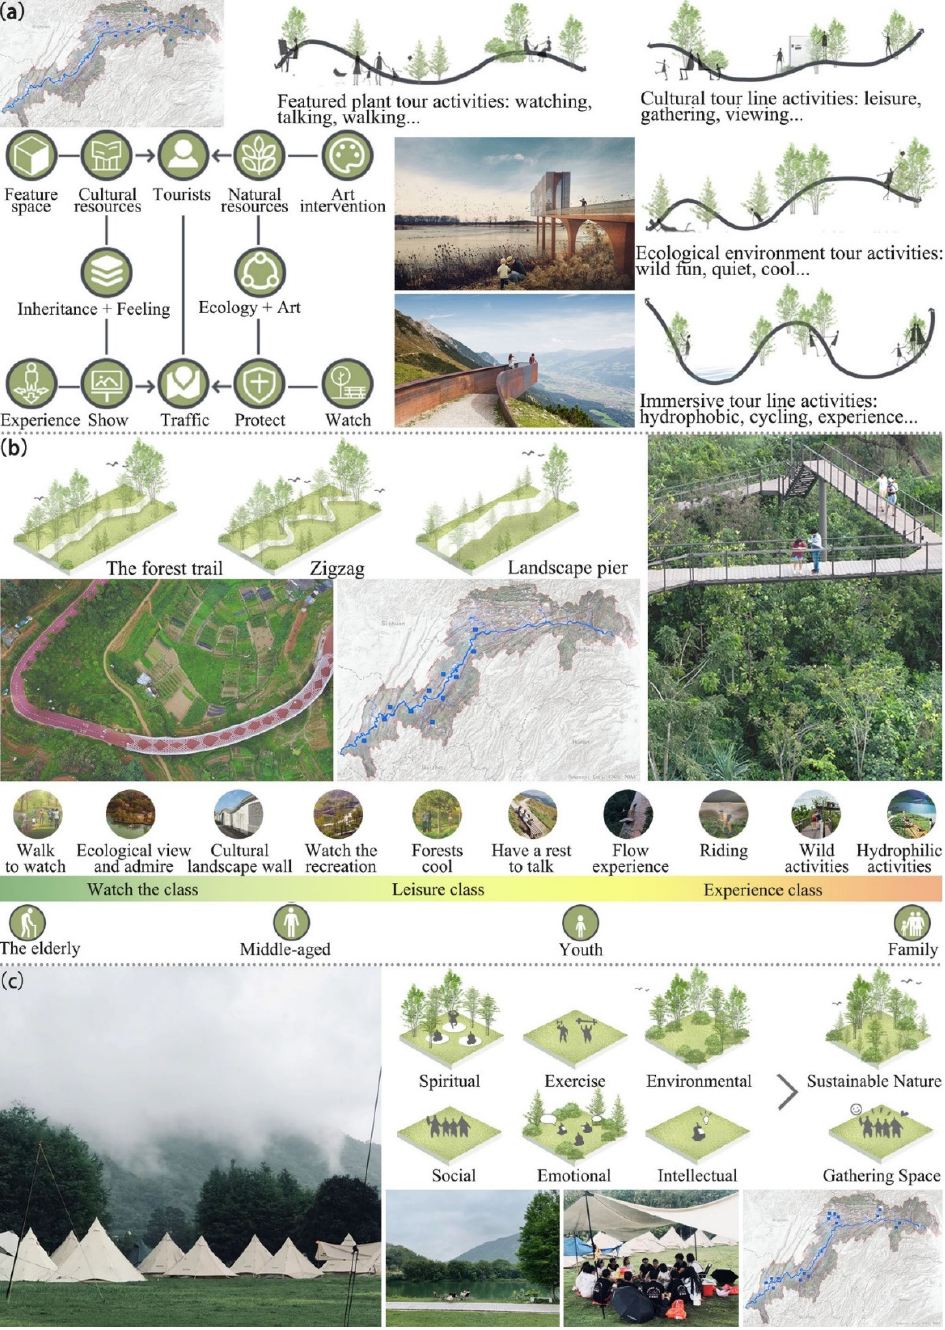
Figure 5. Landscape planning of landscape viewing platforms ( a ), immersive hiking routes ( b ), and gathering spaces ( c ) to attract more visitors and increase the cultural services of the TGRA.